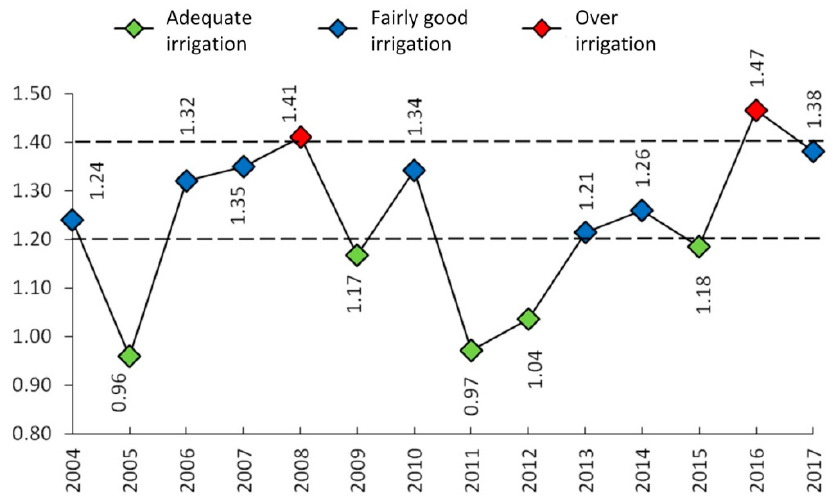
Figure 8. The temporal variation for the annual Relative Water Supply (RWS) for irrigated areas in Egypt